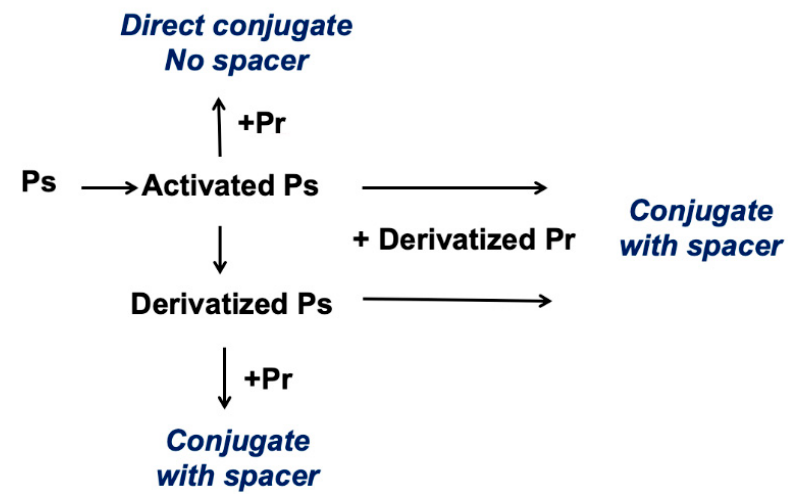
Figure 1. Overview of conjugation of protein to polysaccharide.